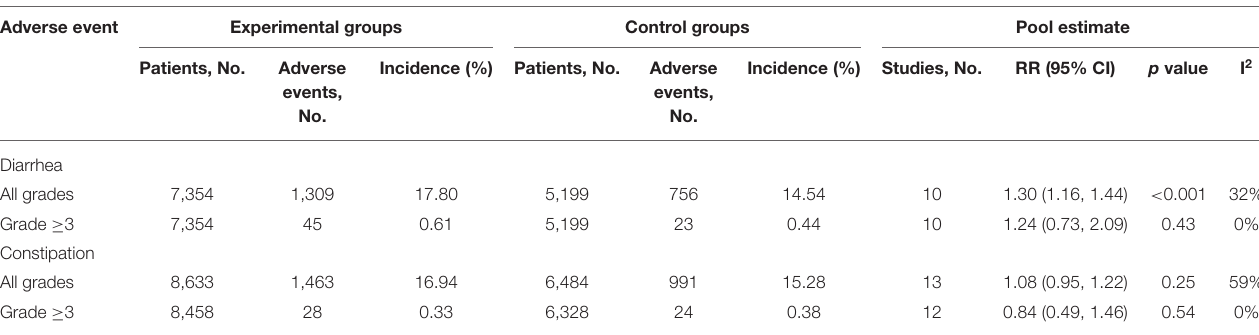
TABLE 3 | Pooled analysis of ARAT use with diarrhea and constipation